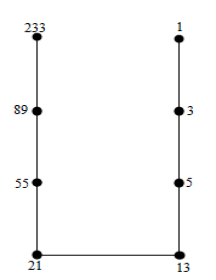
Figure 2.4: Fire Cracker graph